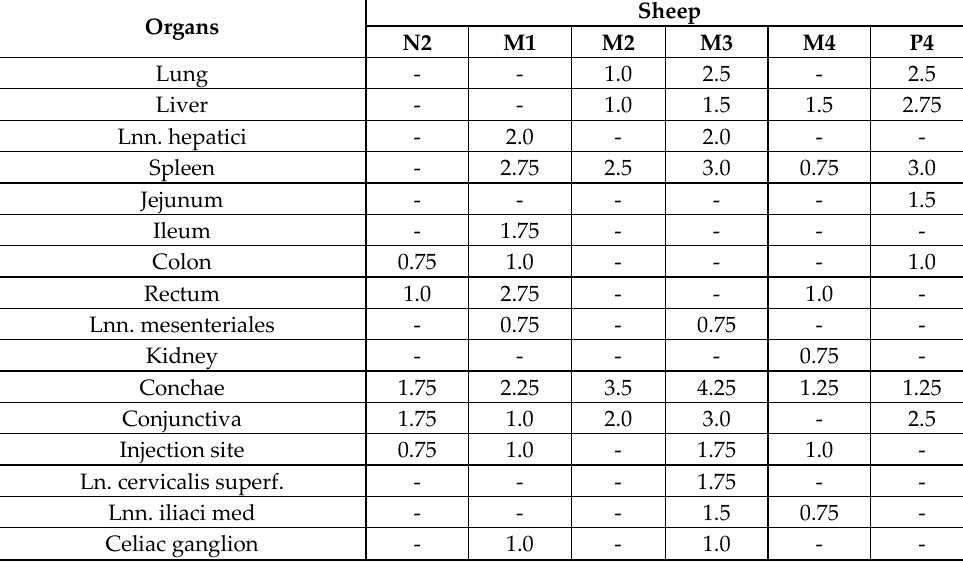
Figure 5. Viral organ loads detected via RT-qPCR in sheep: Results for sheep euthanized 7/8 dpi ( a ) and 27/28 dpi ( b ) are depicted. The boundaries of the boxes indicate the 25th and 75th percentiles, and the line within the box marks the median (calculation performed by Sigmaplot). Table 3. Viral titers (10 x TCID 50 /100 µ L organ homogenate). Table 3. Viral titers (10 x TCID 50 /100µL organ